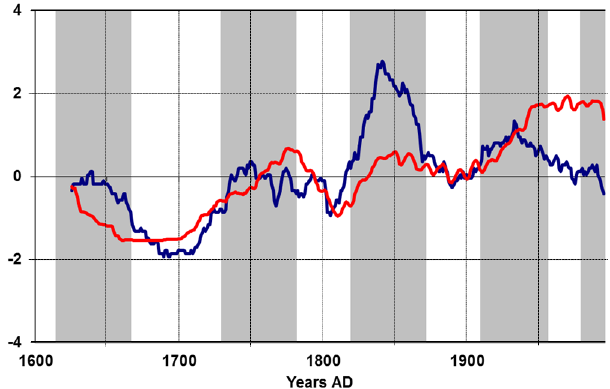
Figure 7. The z -transformed time series of annual 31-year running flood frequencies in the Bavarian Foreland (blue) and “sunspot ac- tivity” (red) since 1610 (data for sunspot activity modified after Hoyt and Schatten, 1997). Grey bars indicate the flood-rich periods #5–#9 based on the full-year development.